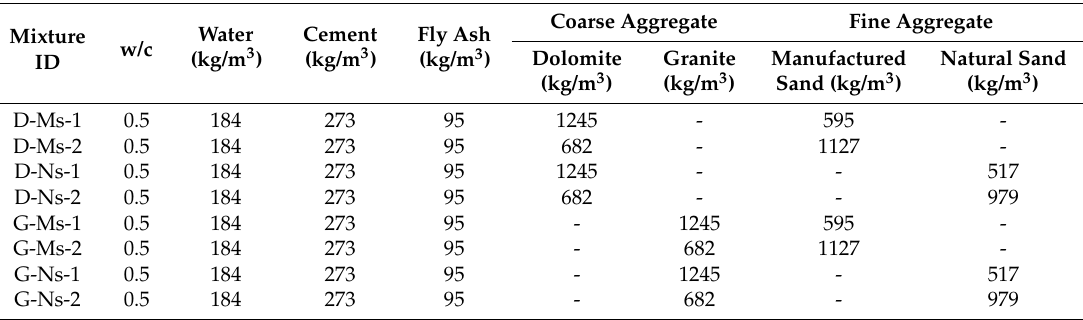
Table 2. Mixture design